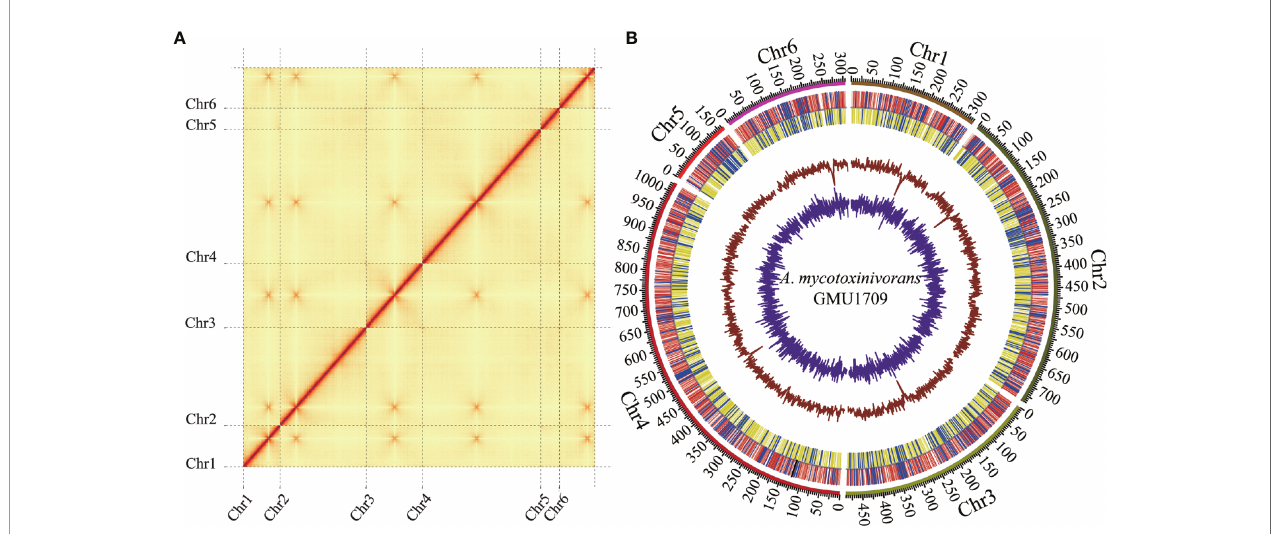
FIGURE 1 | Hi-C assisted assembly of A. mycotoxinivorans GMU1709 genome using LACHESIS software. (A) Hi-C heatmap showing chromosomal interactions under a resolution of 20 kB. Color darkness represent the number of validly mapped Hi-C read pairs between any two bins (20 kB). The contact between centromeres in chromosomes results in strong enrichment of centromere-to-centromere Hi-C links. (B) Circos plot illustrating genomic characteristics. Tracks from outside to the inner correspond to the genome (10 kB), gene distributions on the forward (red) and reverse (yellow) strands (tRNA and rRNA genes marked in blue and black, respectively), GC ratio, and GC